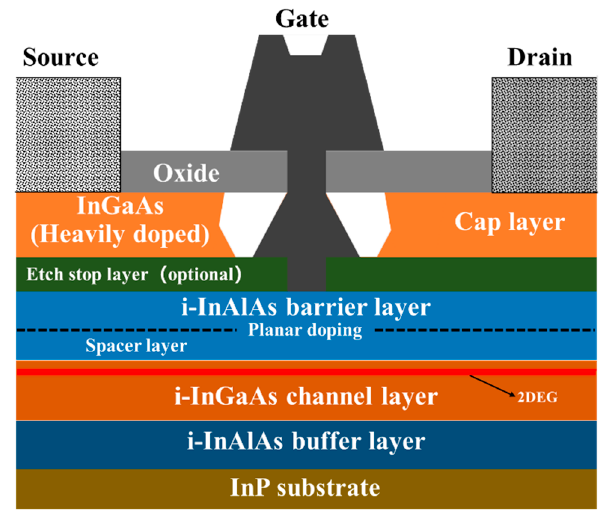
Figure 55. A typical structure of InP HEMT [358].